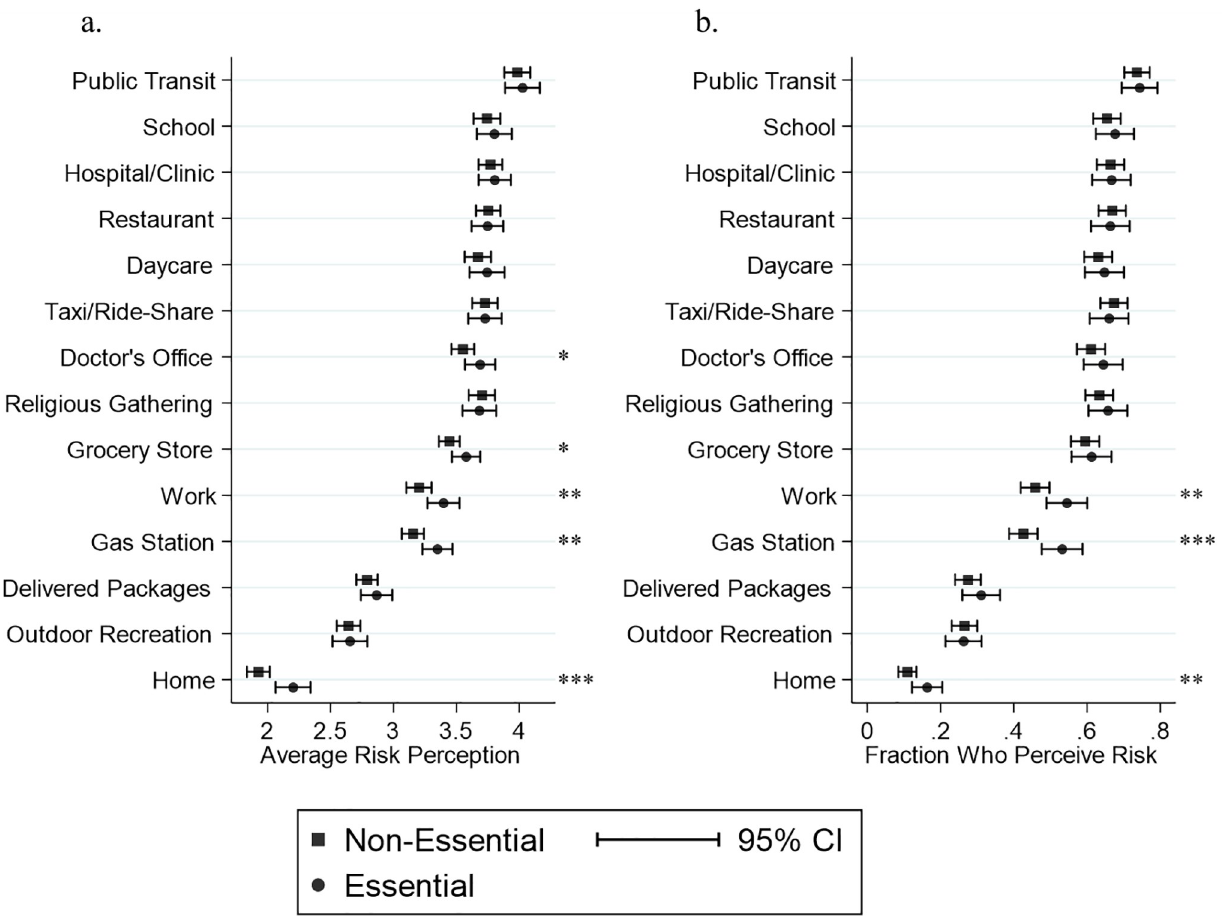
Fig 1. Perceived risk of infection in different places (essential vs. non-essential worker). For each variable, respondents indicated their perceived risk of contracting COVID-19 on a 5-point Likert scale (1 “extremely unlikely”; 2 “somewhat unlikely”; 3 “neither likely nor unlikely”; 4 “somewhat likely”; 5 “extremely likely”). The results are compared across respondents with vs. without an essential worker in the household. � , �� , and ��� indicate significant differences at the 90%, 95%, and 99% respectively. (a) The circles and squares indicate mean responses and the bars are 95% confidence intervals. (b) The circles and squares indicate the fraction of respondents who perceive a risk (i.e., responded “somewhat likely” or “extremely likely”) in each of the places/